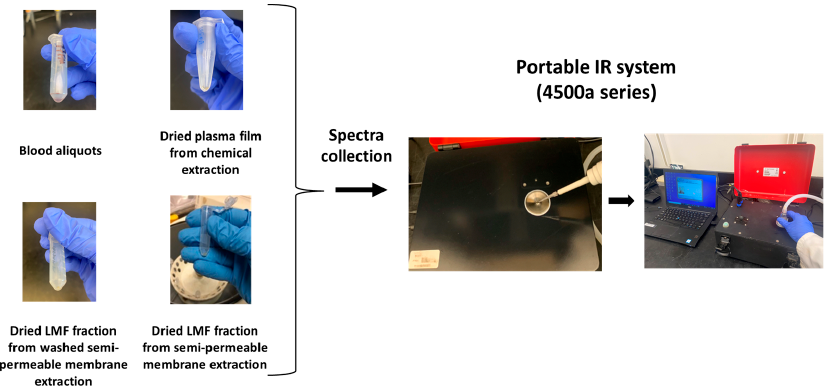
Figure 1. Spectral acquisition of prepared blood samples using a portable FT-IR sensor coupled with triple-reflection diamond attenuated total reflectance (ATR)